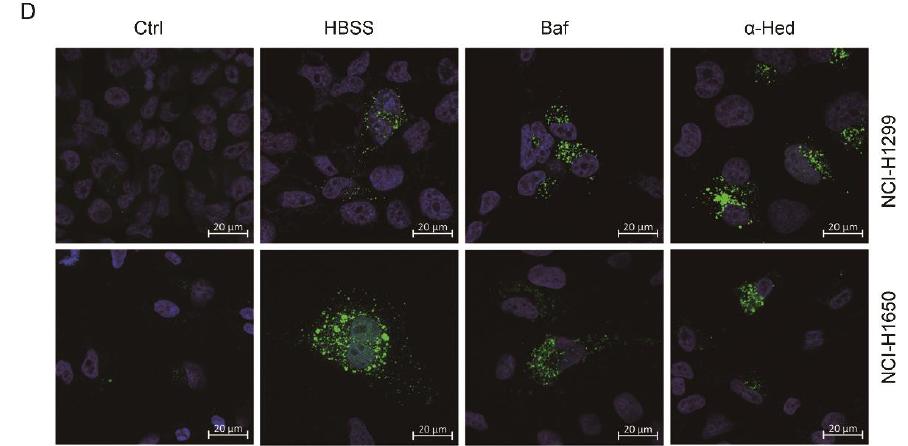
Figure 1. Alpha-hederin ( α -Hed) induced the increased number of autophagosomes in human non-small cell lung cancer (NSCLC) cells. ( A ) The chemical structure of α -Hed. ( B , C ) α -Hed promoted microtubule-associated protein light chain 3 (LC3)-II accumulation in a dose- and time-dependent manner. NCI-H1299 and NCI-H1650 cells were treated with α-Hed (12.5 μM) or bafilomycin A1(Baf, 0.1 μM) for the indicated time courses ( C ), or treated with α-Hed or Baf at the indicated doses for 24 h ( B ). LC3-II was quantified and the fold increase is presented. *** p < 0.001. ( D ) Effect of α-Hed on green fluorescent protein (GFP)-LC3 punctation. NCI-H1299 and NCI-H1650 cells were transiently transfected with GFP-LC3 plasmid, α-Hed (12.5 μM), Baf (0.1 μM) for 24 h, or with Hank’s balanced salt solution (HBSS) for 6 h. Typical images are shown.